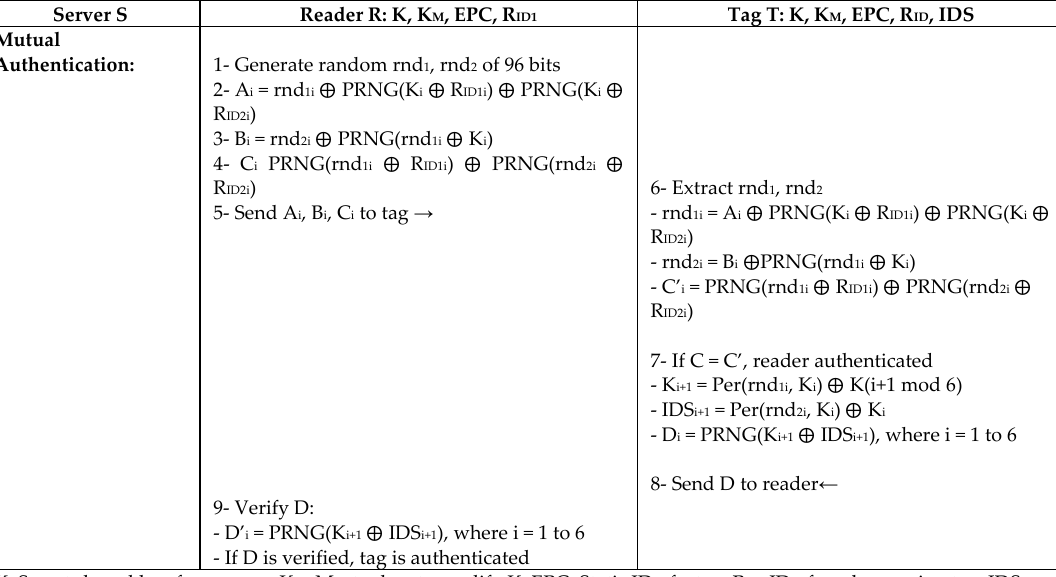
Figure 20. Passive Tag Ownership Authentication Protocol (OMP) Protocol by Niu.